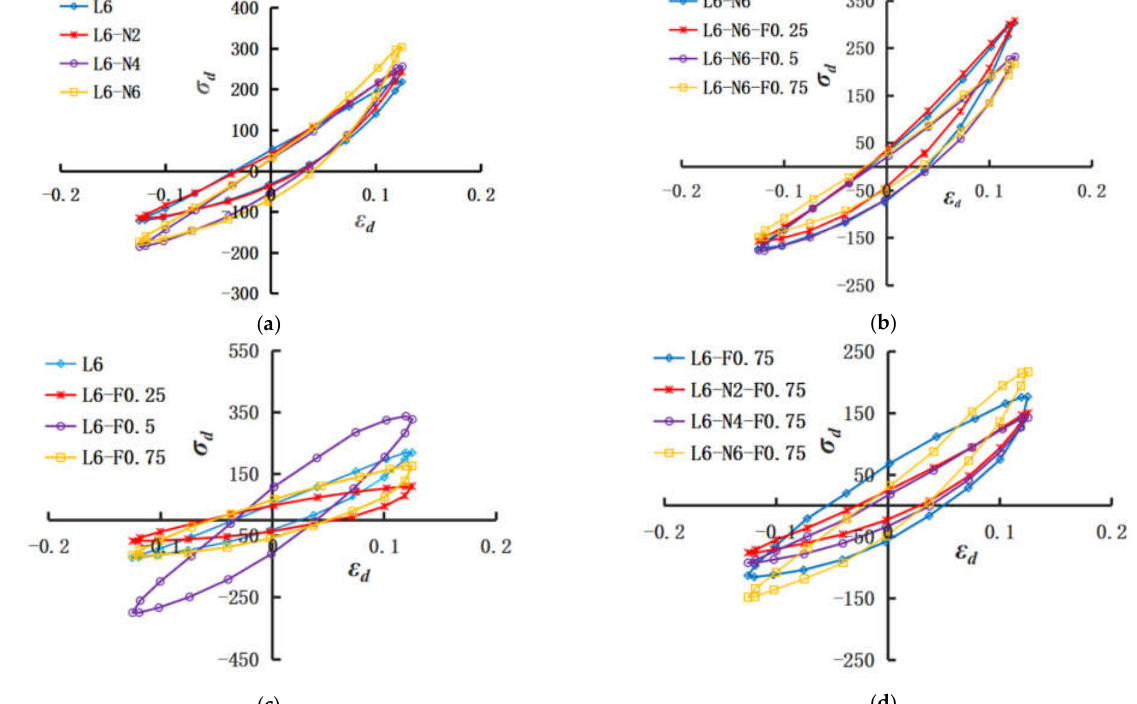
Figure 9. Dynamic stress–strain hysteresis curve: ( a ) change of NLS with nano clay content; ( b ) changes of NFLS (N= 6%) with PPF content; ( c ) changes of FLS with PPF content; ( d ) change of NFLS (F = 0.75%) with nano clay content.